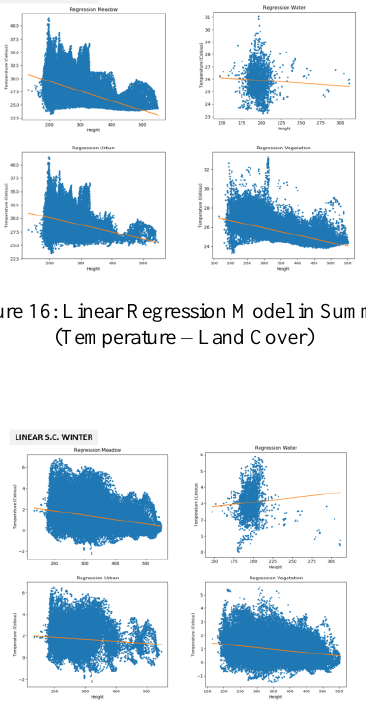
Figure 17: Linear Regression Model in Winter (Temperature – Land Cover)